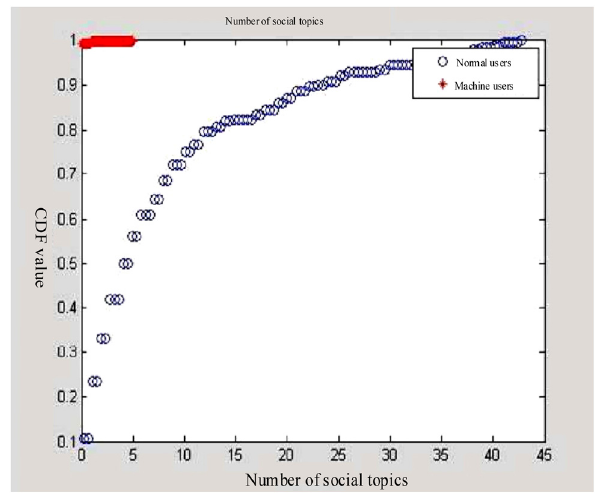
Figure 4: Quantitative extraction results of social network topic number behavior